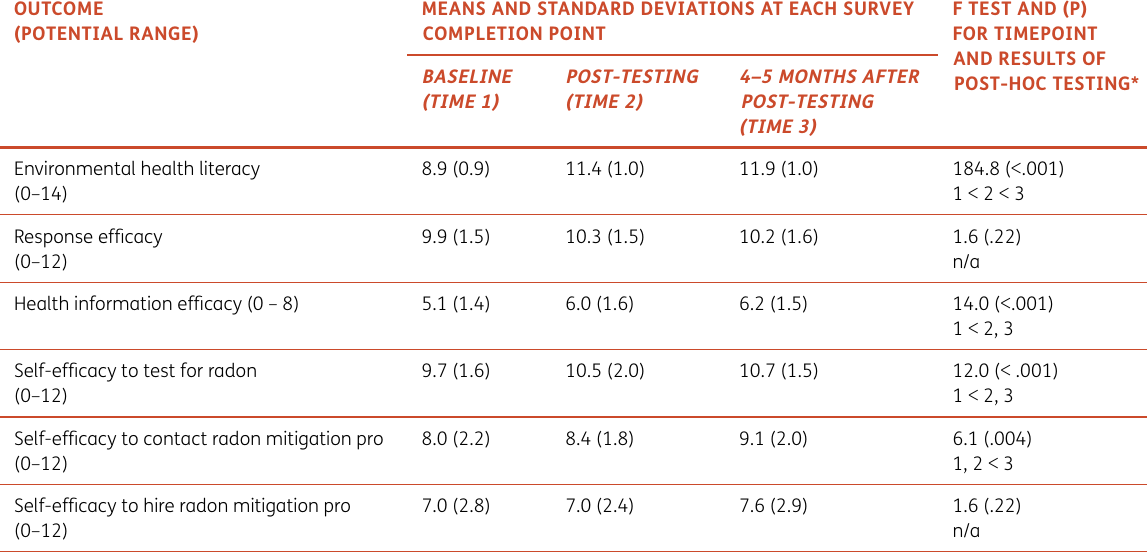
Table 3 Summary of repeated measures mixed models, including means and standard deviations at each timepoint, F tests for the time main effect, and post-hoc testing ( N =